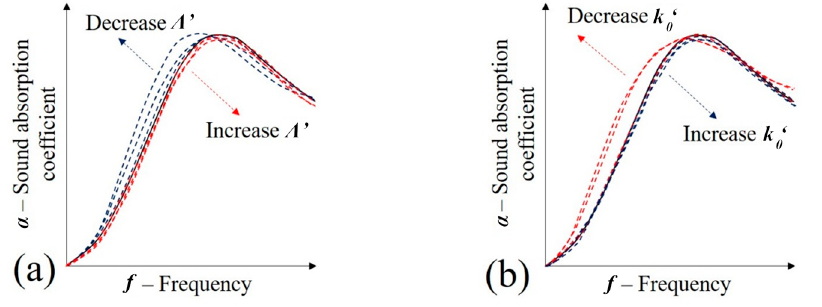
Figure 15. Influence of visco-thermal parameters in the sound absorption coefficient of porous media (JCAL model): ( a ) Λ (cid:48) —thermal characteristic length; and ( b ) k (cid:48) 0 —static thermal permeability. The frequency-dependent dynamic thermal permeability ( k (cid:48) ( ω ) ) may be calculated using Equation (13), being dependent on the differentials of pressure and time ( ∂ P / ∂ t ), porosity ( Φ ), air thermal conductivity ( k ) and excess of the temperature inside the cellular solid ( τ ) [40,42]. The static thermal permeability ( k (cid:48) 0 ) relates thermal effects between the rigid frame and the fluid at low frequencies actuating in the boundary layer, according